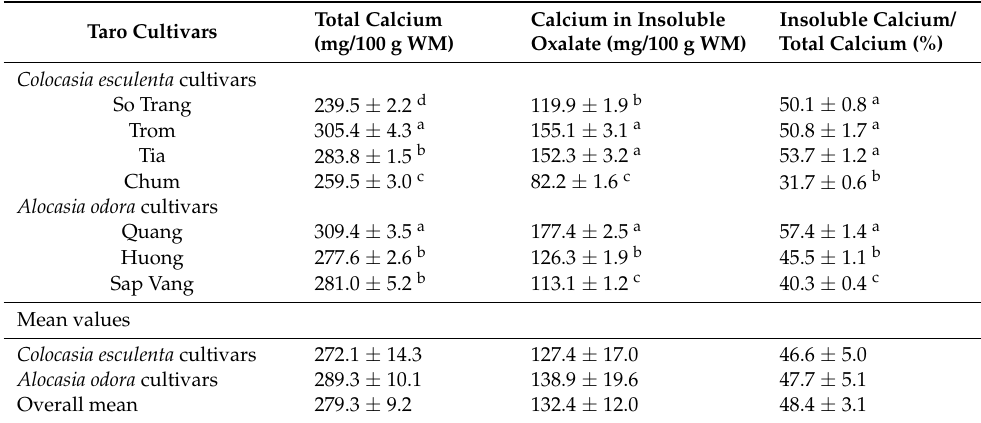
Table 3. Mean values ( ± SE) for total calcium content (mg/100 g WM) and calcium in insoluble oxalate in the leaves of seven different taro cultivars grown in central